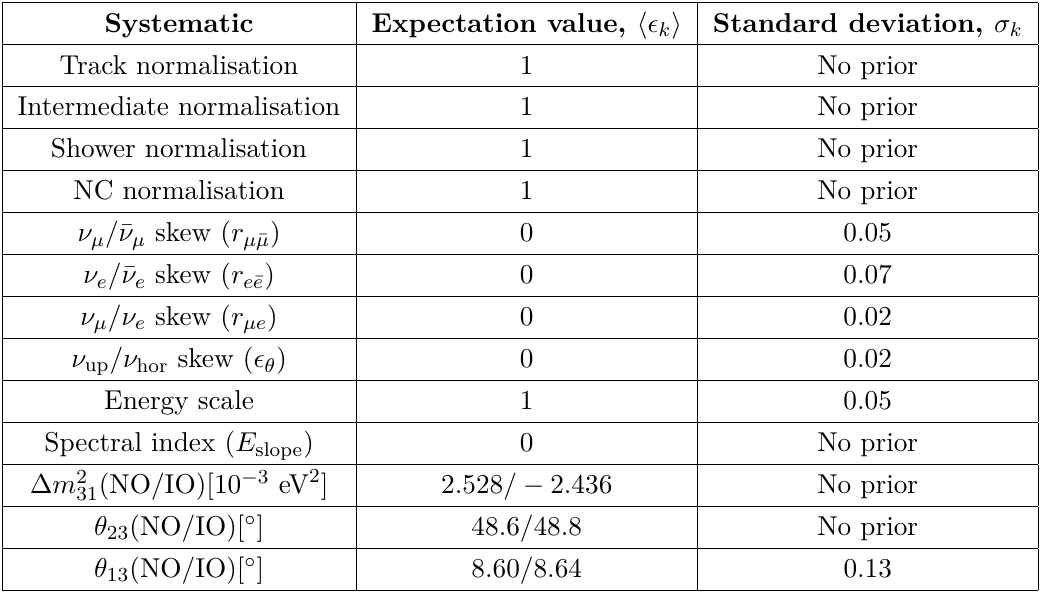
Table 3. List of systematic parameters used in the fitted model with their corresponding priors. Their expectation values are used to generate the observed Asimov dataset ( N dat fitted when computing the number of expected events in the model ( N mod